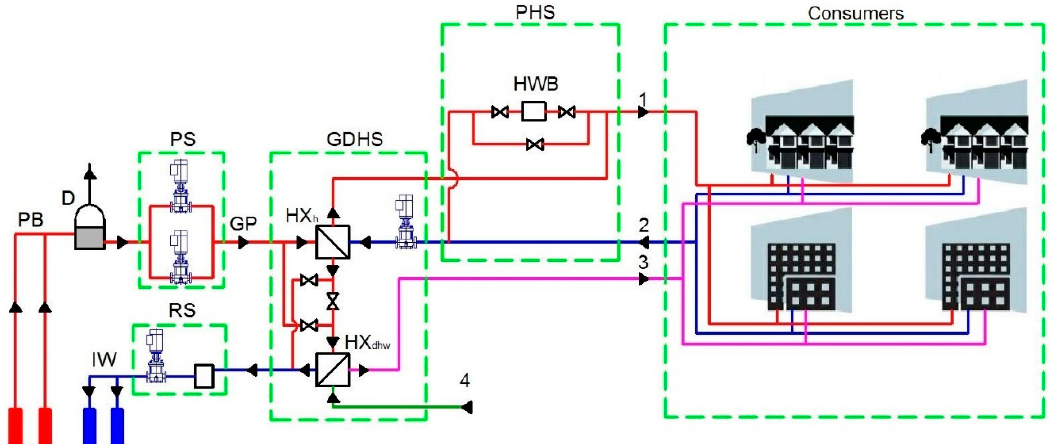
Figure 6. Schematic of a district heating system (DHS) utilising geothermal energy: PB—production